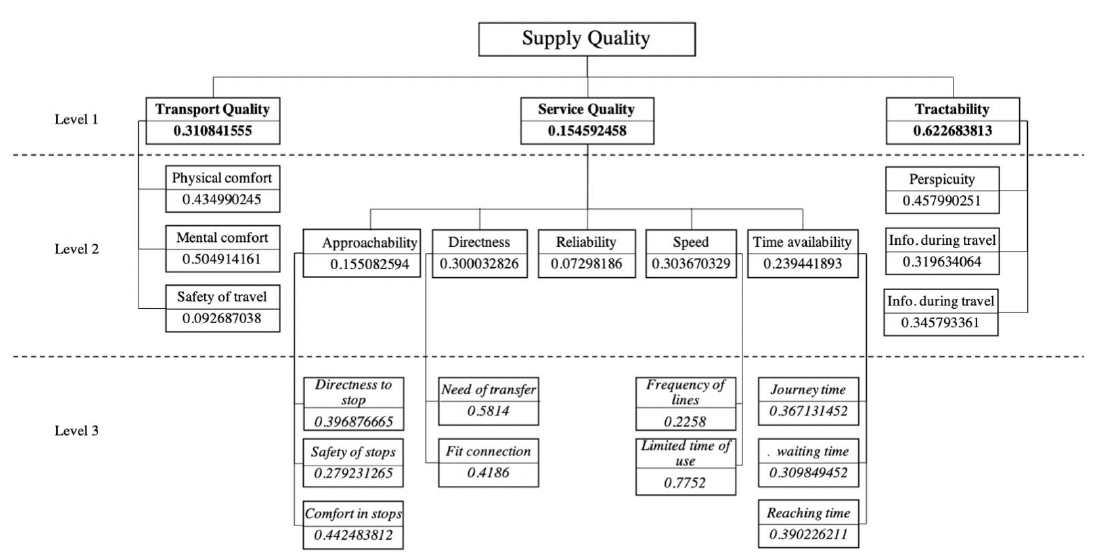
Figure 3. The fuzzy weights for public transport supply quality criteria. Table 2. Final fuzzy scores of the criteria for Level 1.